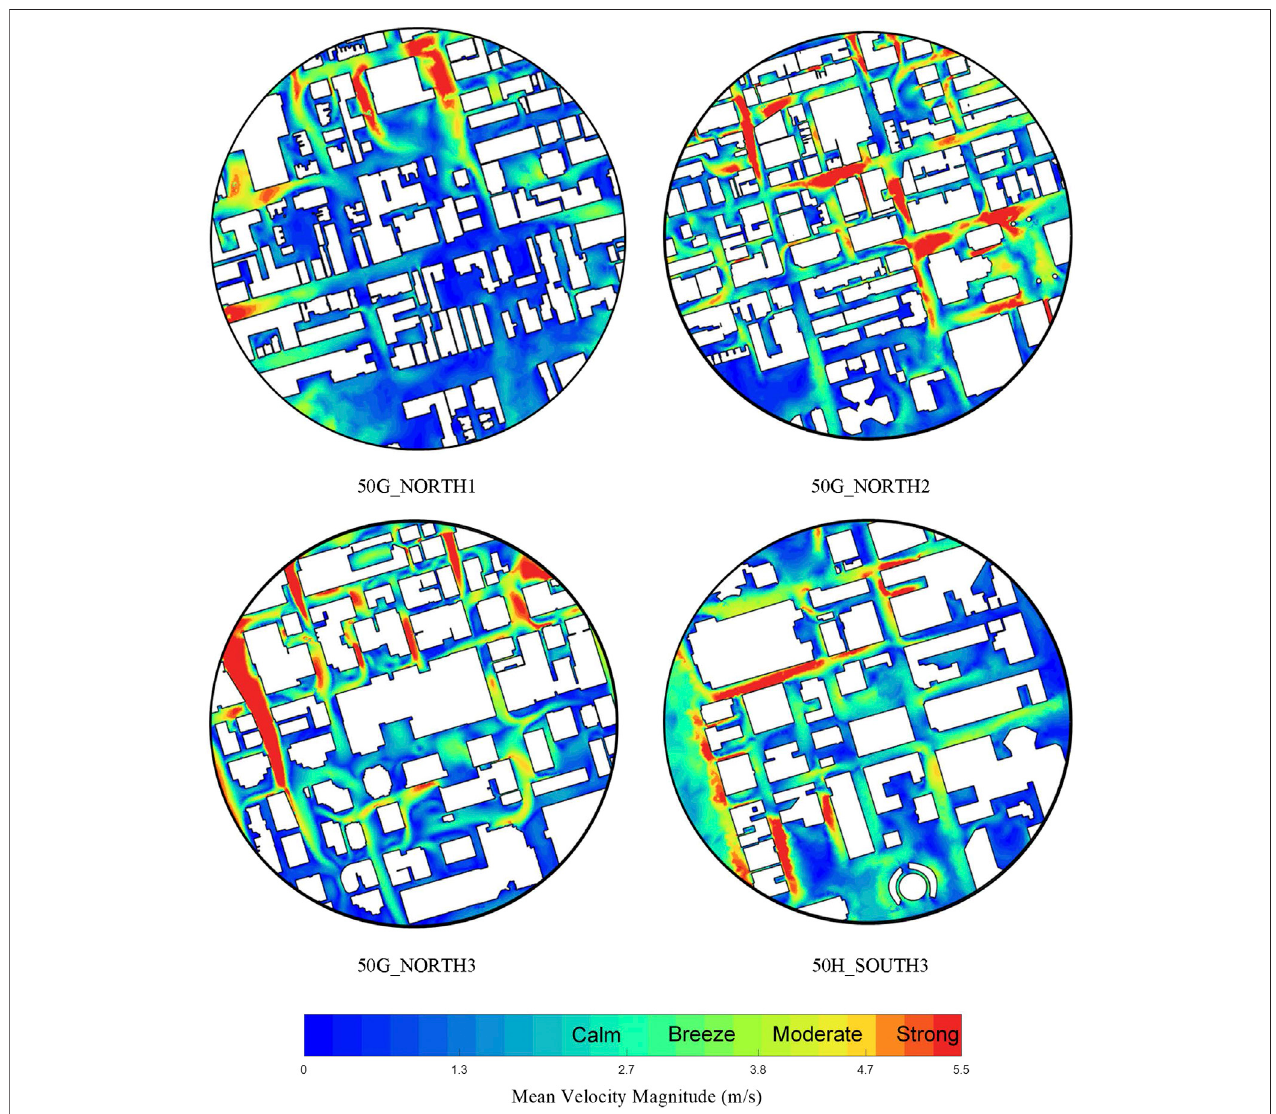
FIGURE 13 | Peak PLW Velocity contours using a one-year return period.